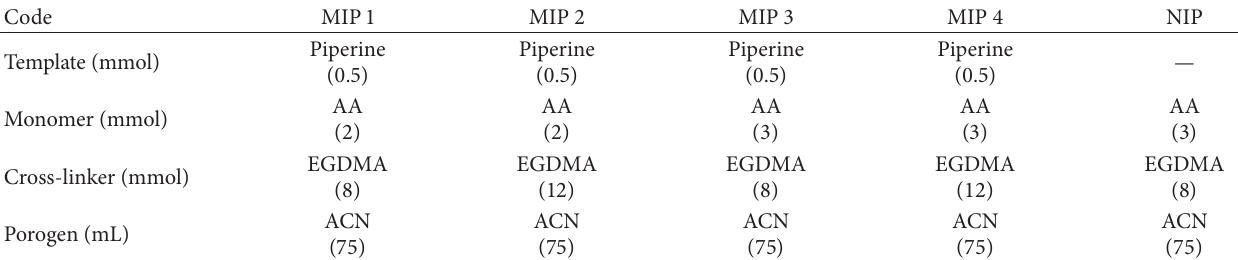
Table 1: Synthesis of molecularly imprinted polymers and nonimprinted polymer for Piperine by precipitation